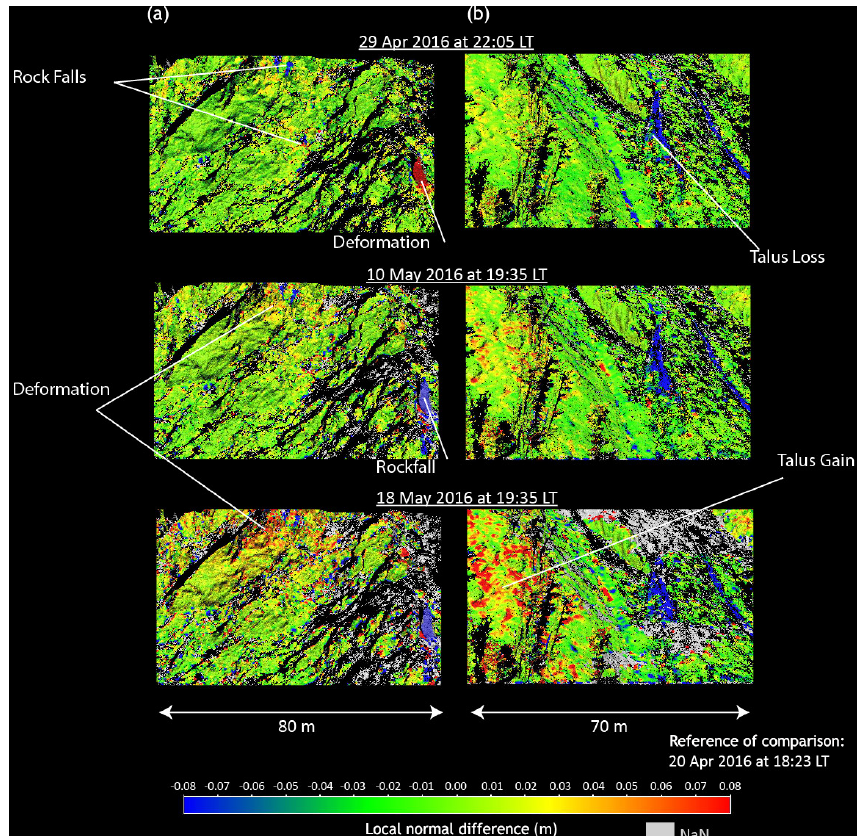
Figure 10. Change Detection results for three sub areas identified in Fig. 9 showing the flux of talus, deformation of the landslide and